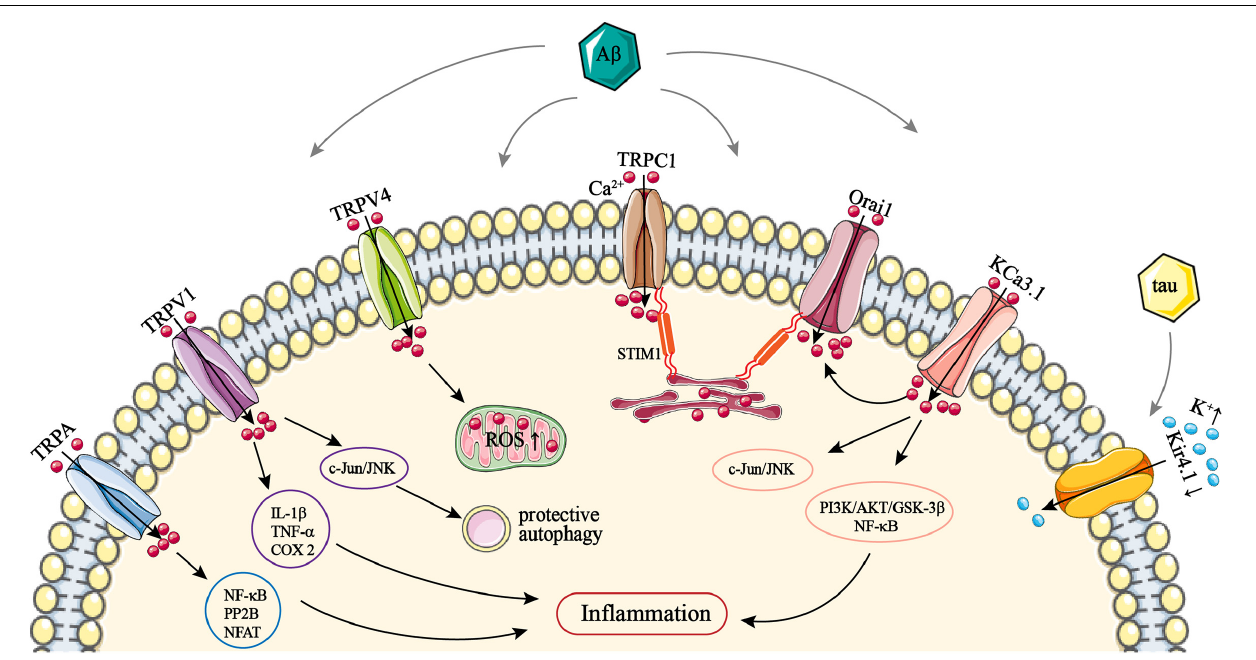
FIGURE 1 | The role of astrocytic TRPA, TRPC1, TRPV1/4, Orai1, KCa3.1, and Kir4.1 channels in AD. TRPA, TRPV1, and TRPV4 channels are all activated by A β and thus mediate Ca 2 + influx, resulting in intracellular Ca 2 + overload. Ca 2 + entry via TRPA can activate NF- κ B, PP2B, and NFAT. Ca 2 + influx via TRPV1 can upregulate the expression of IL-1 β , TNF- α , and COX-2. All of these can promote astrocytic inflammatory responses. Activation of c-Jun/JNK by Ca 2 + via TRPV1 can induce protective autophagy in astrocytes. Ca 2 + entry via TRPV4 can lead to ROS production. STIM1 on the astrocytic ER membrane recruits TRPC1 trafficking vesicles anchored to the plasma membrane, and mediating Ca 2 + influx via a STIM1–TRPC1 complex. STIM1 also associates and activates Orai1; this also facilitates Ca 2 + entry via a STIM1–Orai1 complex. Both TRPC1 and Orai1 can be upregulated by A β , which promotes SOCE-mediated Ca 2 + influx. Astrocytic KCa3.1 channels can activate Orai1, and then also facilitate Ca 2 + entry via the STIM1–Orai1 complex. KCa3.1 can also mediate Ca 2 + influx directly and subsequently activate PI3K/AKT/GSK-3 β , NF- κ B, and c-Jun/JNK pathways, which promote astrocyte hyperactivation. Kir4.1 channels mediate K + influx; A β and tau can downregulate astrocytic Kir4.1, which leads to an excessive extracellular K + concentration. AD, Alzheimer’s disease; A β , amyloid- β ; AKT, protein kinase B; COX-2, cyclooxygenase 2; ER, endoplasmic reticulum; GSK-3 β , glycogen synthase kinase 3; IL-1 β , interleukin-1 β ; JNK, c-Jun N-terminal kinase; Orai1, Ca 2 + release-activated Ca 2 + channel protein 1; NF- κ B, nuclear factor κ B; NFAT, nuclear factor of activated T-cells; PI3K, phosphoinositide 3-kinase; PP2B, serine/threonine-protein phosphatase 2B; ROS, reactive oxygen species; SOCE, store-operated Ca 2 + entry; STIM1, stromal interacting molecule 1; TNF- α ,